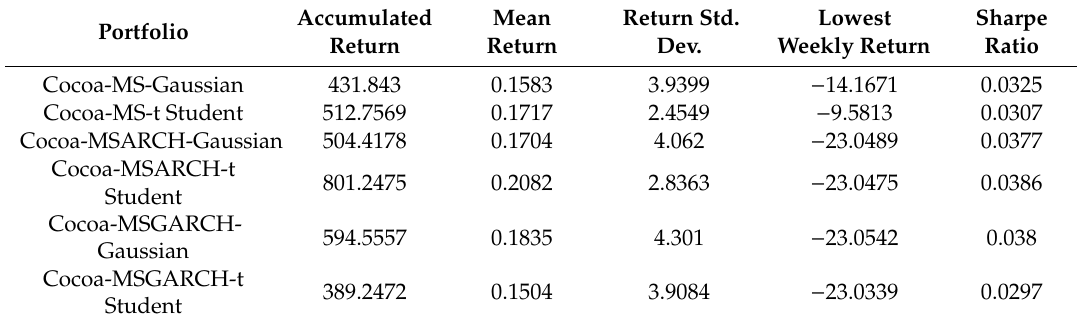
Table 4. Performance summary of the simulated portfolios in the cocoa one-month futures’ market (figures in %, with the exception of the Sharpe ratio).